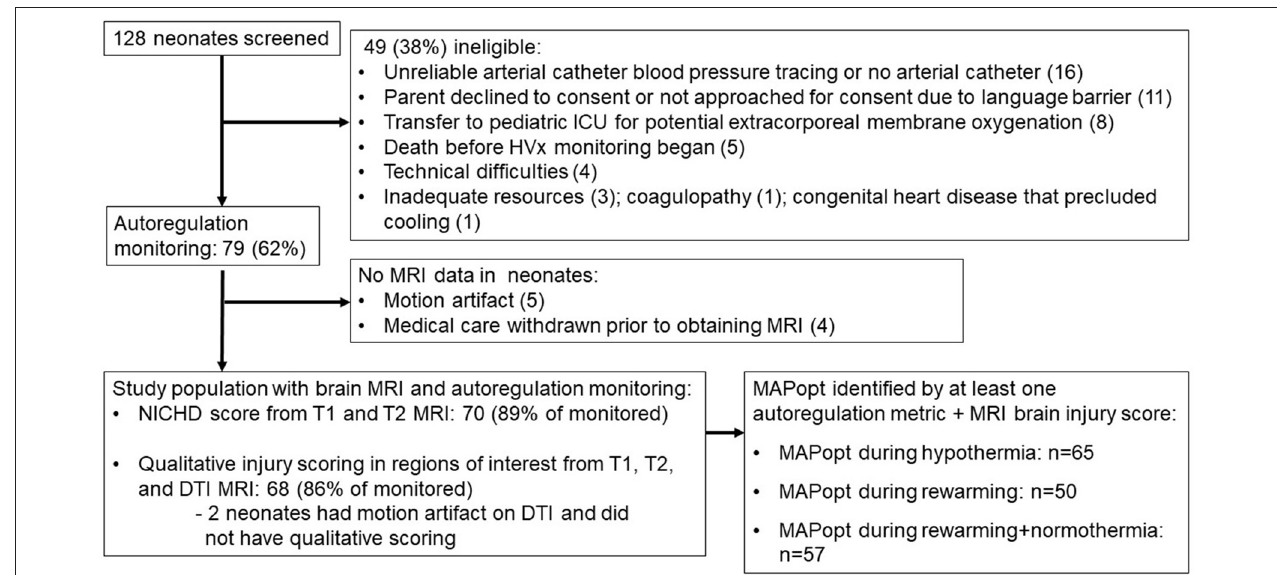
FIGURE 3 | Study screening and enrollment. ICU, intensive care unit; MRI, magnetic resonance imaging; NICHD, National Institute of Child Health and Human Development; DTI, diffusion tensor imaging; MAPopt, optimal mean arterial blood pressure.